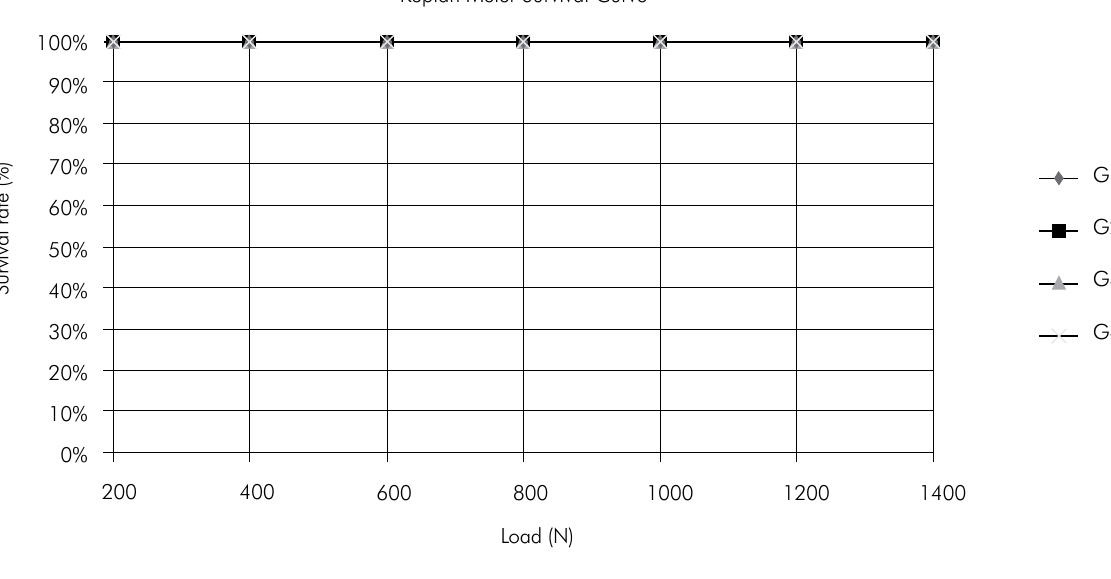
Figure 3. Kaplan-Meier survival curves for 4 different surrounding wall thicknesses (2.0 mm, 1.5 mm, 1.0 mm and 0.5 mm). All specimens survived the fatigue